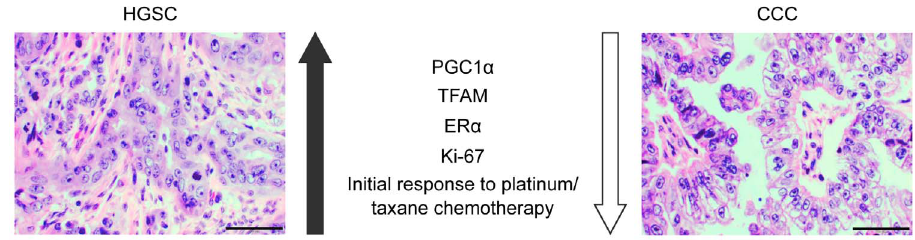
Figure 5. Comparison of ovarian HGSC and CCC. Representative hematoxylin and eosin staining of ovarian HGSC and CCC. We hypothesise that these subtypes represents extreme forms of EOC; HGSC generally display positive expression of PGC1 a , TFAM and ER a , have a higher Ki-67 index and are more responsive to initial platinum/taxane chemotherapy. By contrast, CCC generally do not express PGC1 a , TFAM and ER a , have a lower Ki- 67 index and are less responsive to initial platinum/taxane chemotherapy. Magnification 400x, scale bar shows 50 m m.